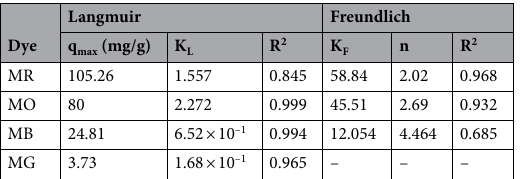
Table 3. The isotherms constants of adsorption models for various